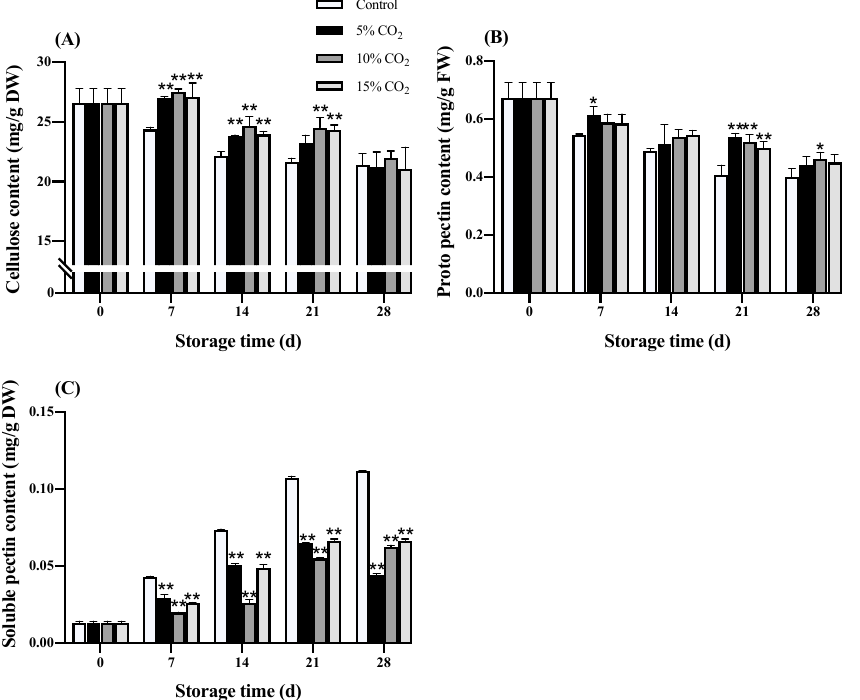
Figure 4. Effects of elevated CO 2 on cellulose content ( A ), proto pectin content ( B ), and soluble pectin content ( C ) in wolfberry during storage at 0 ± 0.5 °C for 28 d. Significant level * p < 0.05; ** p < 0.01.